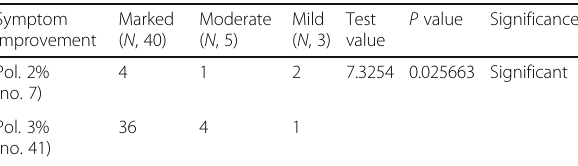
Table 8 The correlation between polidocanol concentration injected and the symptomatic correlation Symptom Marked improvement ( N , 40)